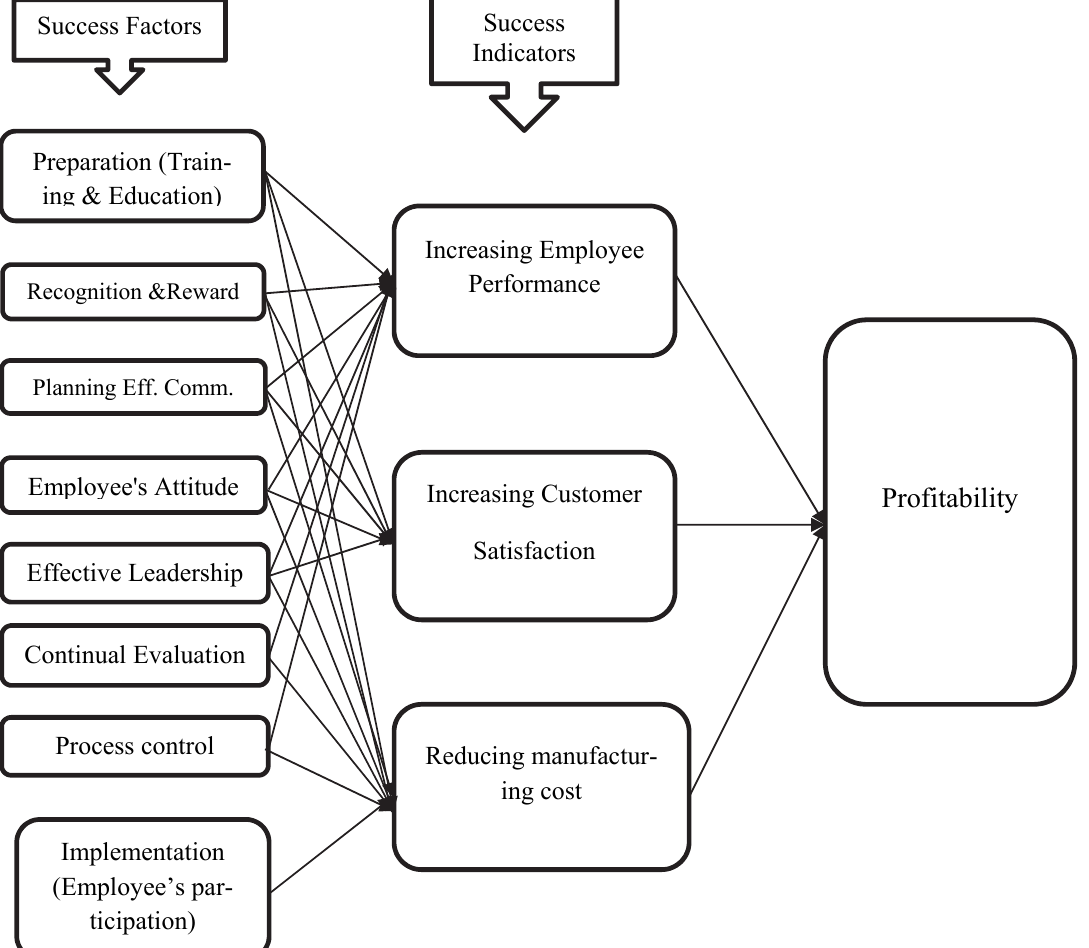
Fig. 4. New model developed after empirically